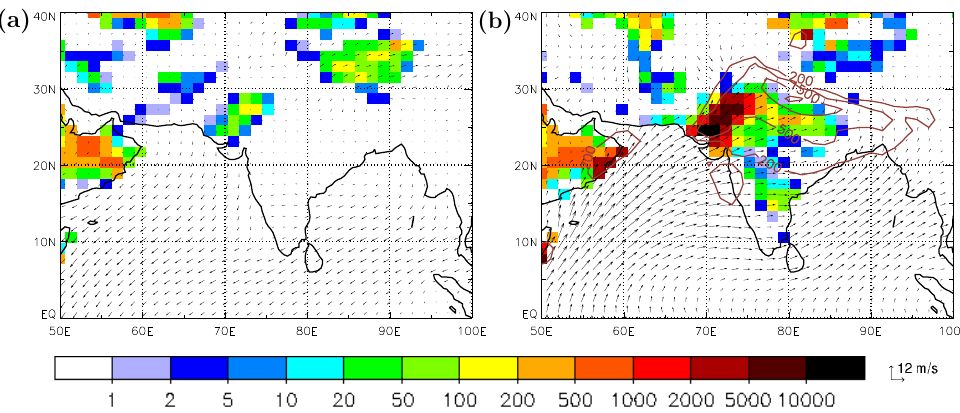
Fig. 4. Mean dust emission (kg ha − 1 , shading), deposition (brown isolines for 200, 500, 1500, and 3000 kg ha − 1 ), and the wind on the lowest model layer (arrows) over the Indian subcontinent during DJF (a) and JJA (b) in the simulation T85TG.